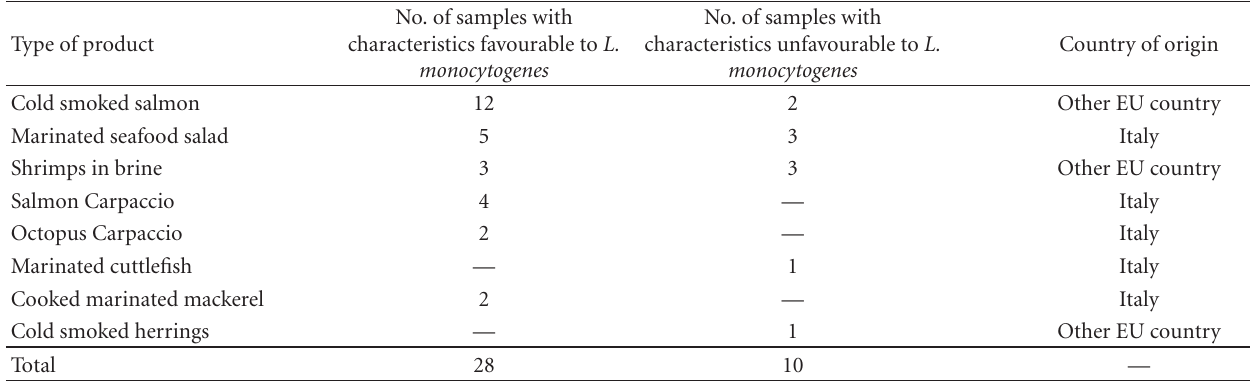
Table 1: Types of ready-to-eat seafood, country of origin.